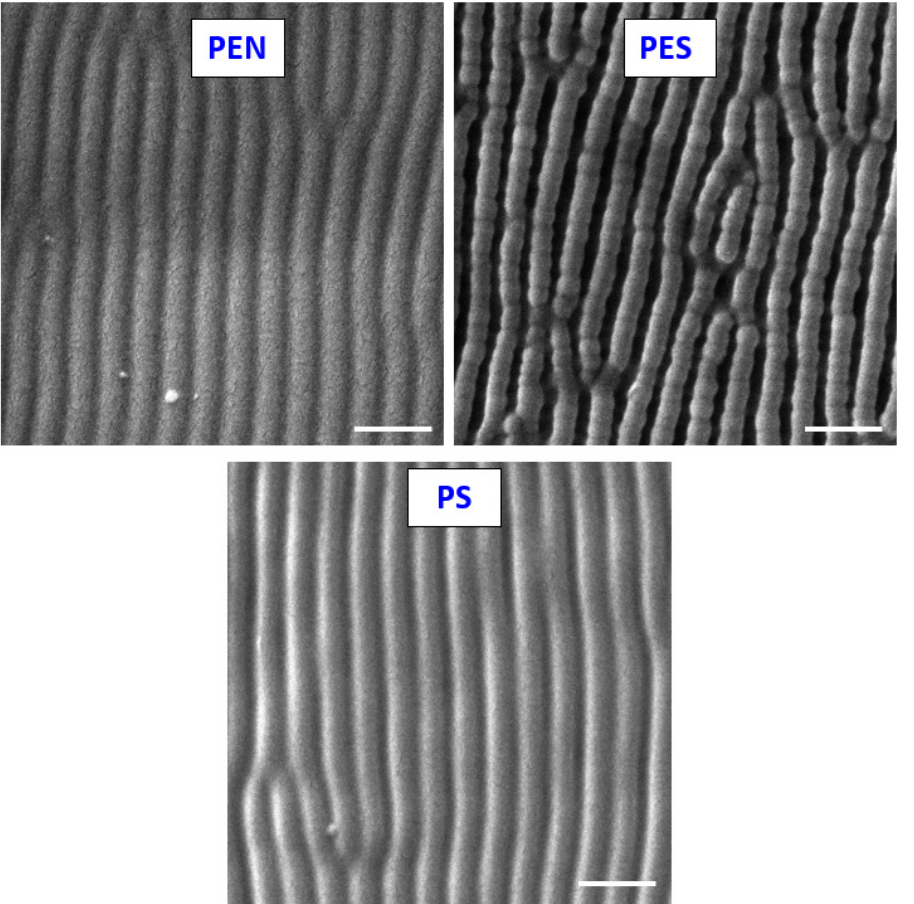
Figure 1. Scanning electron microscopy images of PEN, PES, and PS foil treated by KrF laser with the laser fluence of 10 mJ·cm − 2 with 6000 pulses. The white line represents 500 nm.